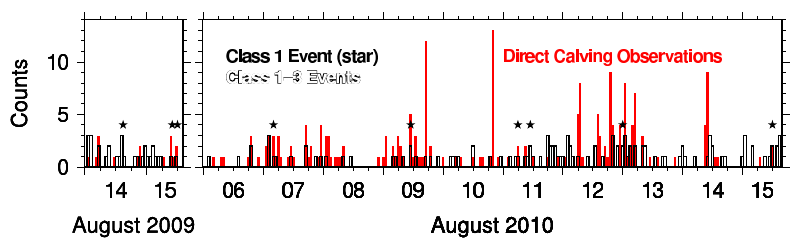
Fig. 4. Temporal distribution of direct (visual) calving observations and Class 1–3 seismic events within calibration period in 2009 and 2010.